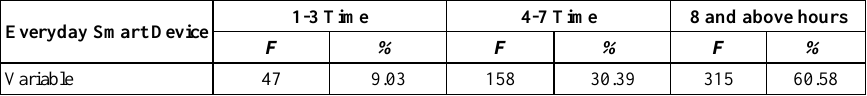
Table 2. Distribution of university students regarding daily smart device time